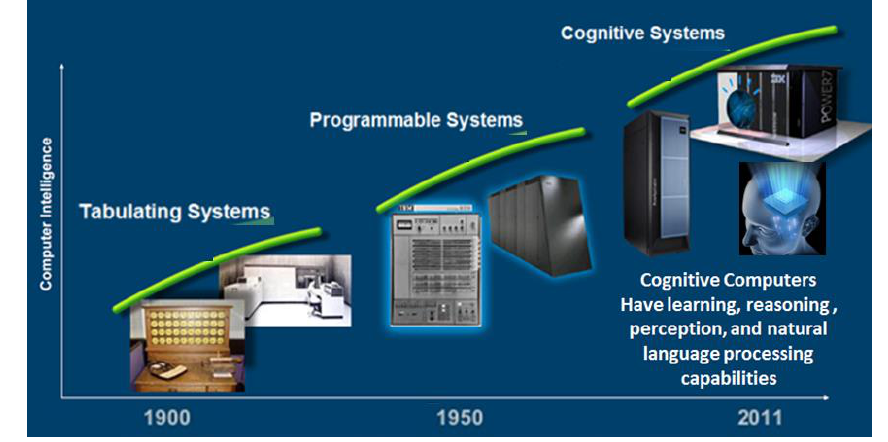
Figure 1: Three Eras of Computing (based on